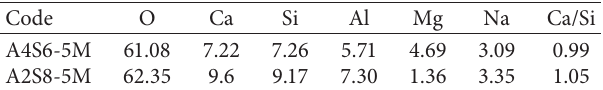
Figure 11: SEM/EDS photograph of A2S8-5M at 28d curing time. Table 3: A4S6-5M and A2S8-5M conclusions of atomic ratio at 28d curing time